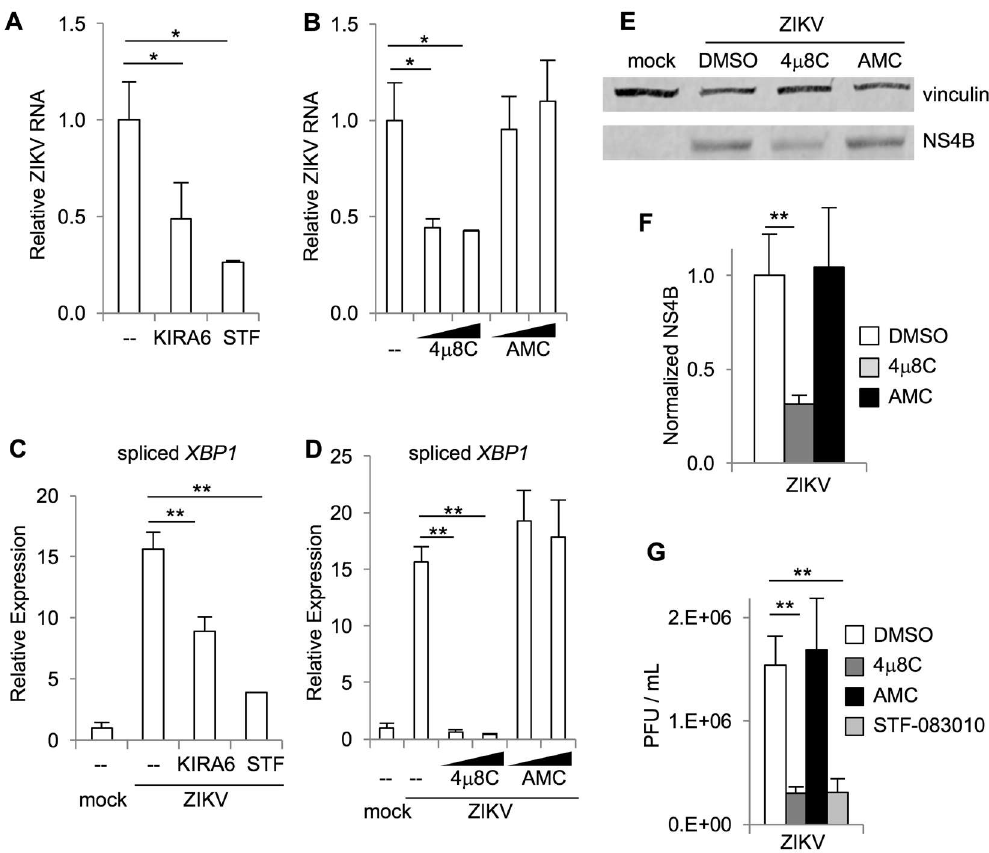
Figure 3. IRE1 α inhibitors reduce ZIKV replication. Cells were treated with small molecule inhibitors or DMSO solvent control prior to infection with ZIKV. RNA was harvested two days post-infection and the relative abundance of ZIKV RNA ( A + B ) and spliced XBP1 mRNA ( C + D ) were determined by quantitative RT-PCR. Data are means ± SD of three replicates and are representative of at least two independent experiments. The relative abundance of viral NS4B and vinculin loading control in cell lysates two days post-infection was determined by Western blotting and densitometry ( E ). The ratio of sXBP1 to vinculin is shown, normalized to uninfected cells ( F ). Data are means ± SD of three independent experiments. Viral titers in the cell culture medium were measured by plaque assay ( G ). PFU, plaque-forming units. Data are means ± SD of six replicates and are representative of three independent experiments. * p < 0.05, ** p < 0.01, by unpaired t test.